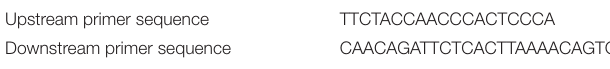
TABLE 1 | The primer sequence of this single gene sequencing. Upstream primer